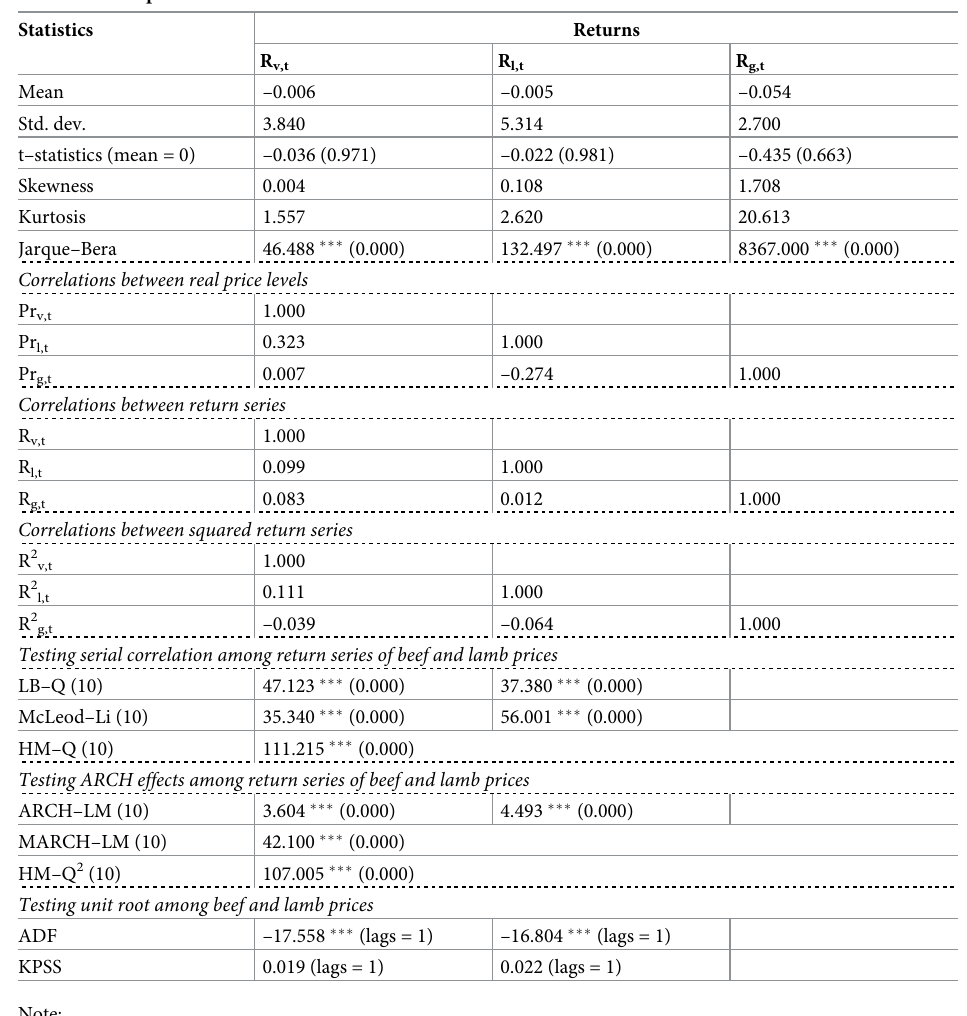
Table 2. Descriptive statistics and unit root test